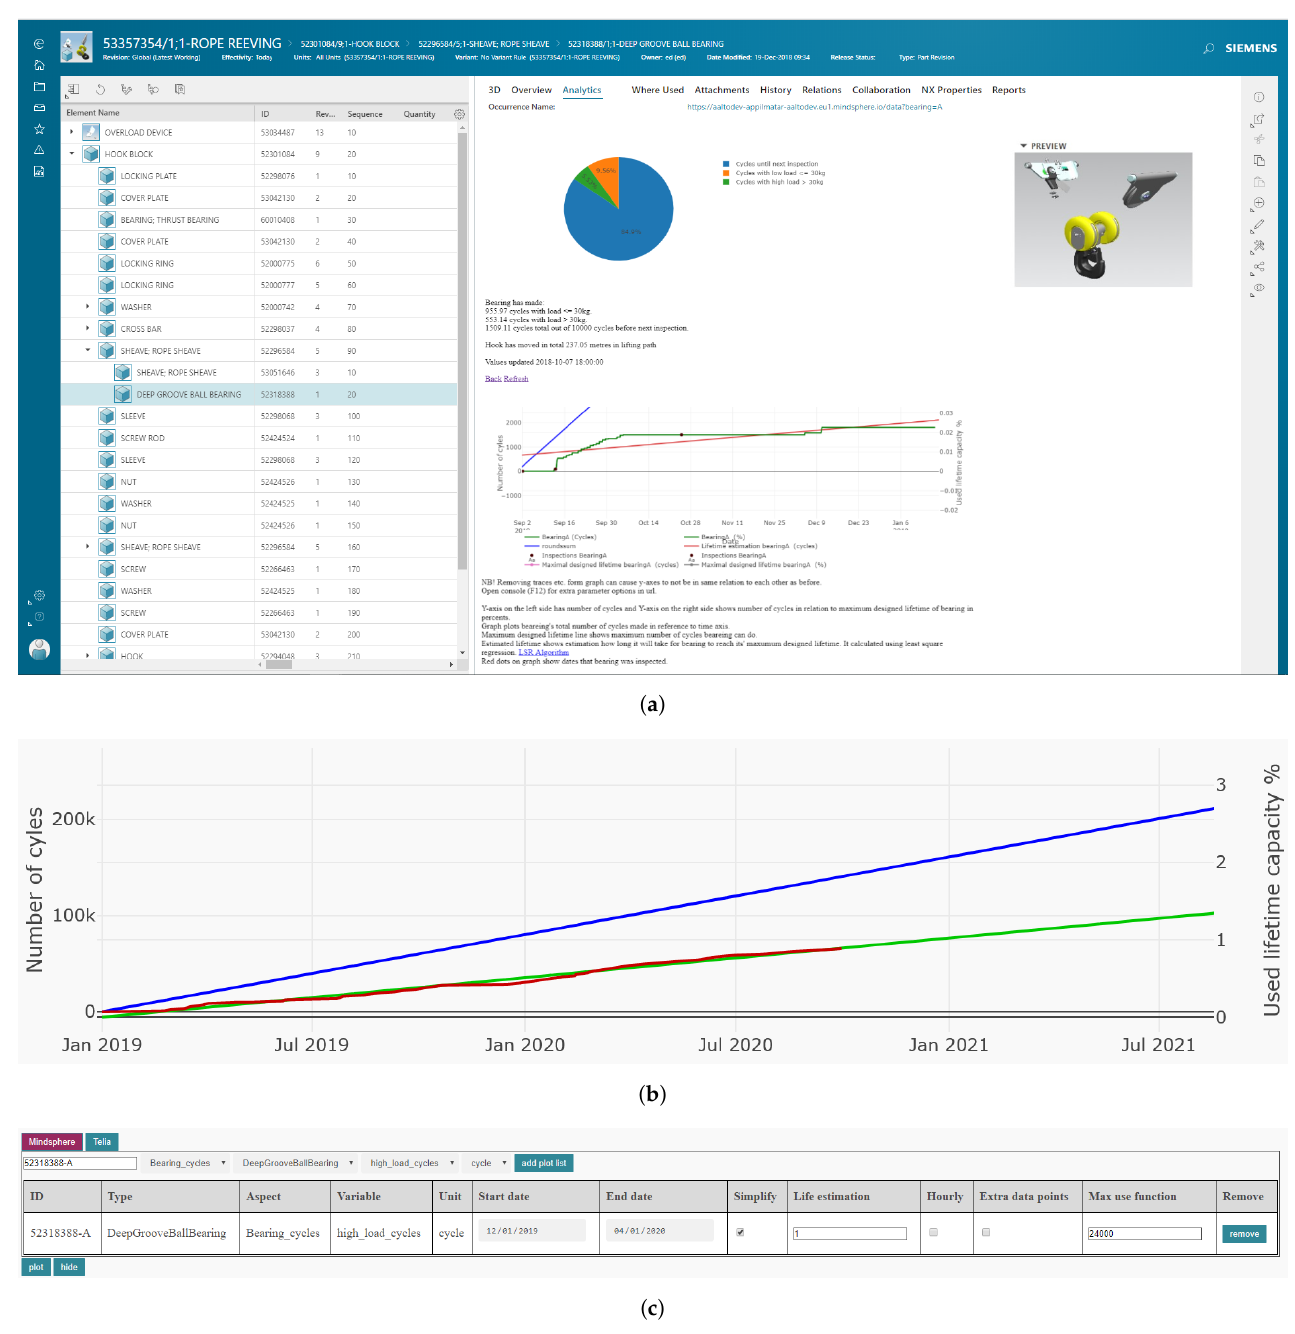
Figure 6. Screenshot samples of user interfaces for the bearing lifetime estimation case. ( a ) Product lifecycle management (PLM) software Teamcenter showing bearing usage data. The pie chart shows the types of usage and the graph shows timewise usage. The number of cycles is calculated from true usage data of the Ilmatar crane and the inspections are mockup for proof-of-concept visualization purposes. ( b ) A graph visualizing the past use (red curve), predicted expenditure according to the past usage (green), and the allowed linear usage to achieve the designed number of cycles (blue) in the designed lifetime of one of the bearings in the Ilmatar crane. The chosen lifetime for drawing the blue line is 100 years. ( c ) The user interface for selecting the information to be displayed on the